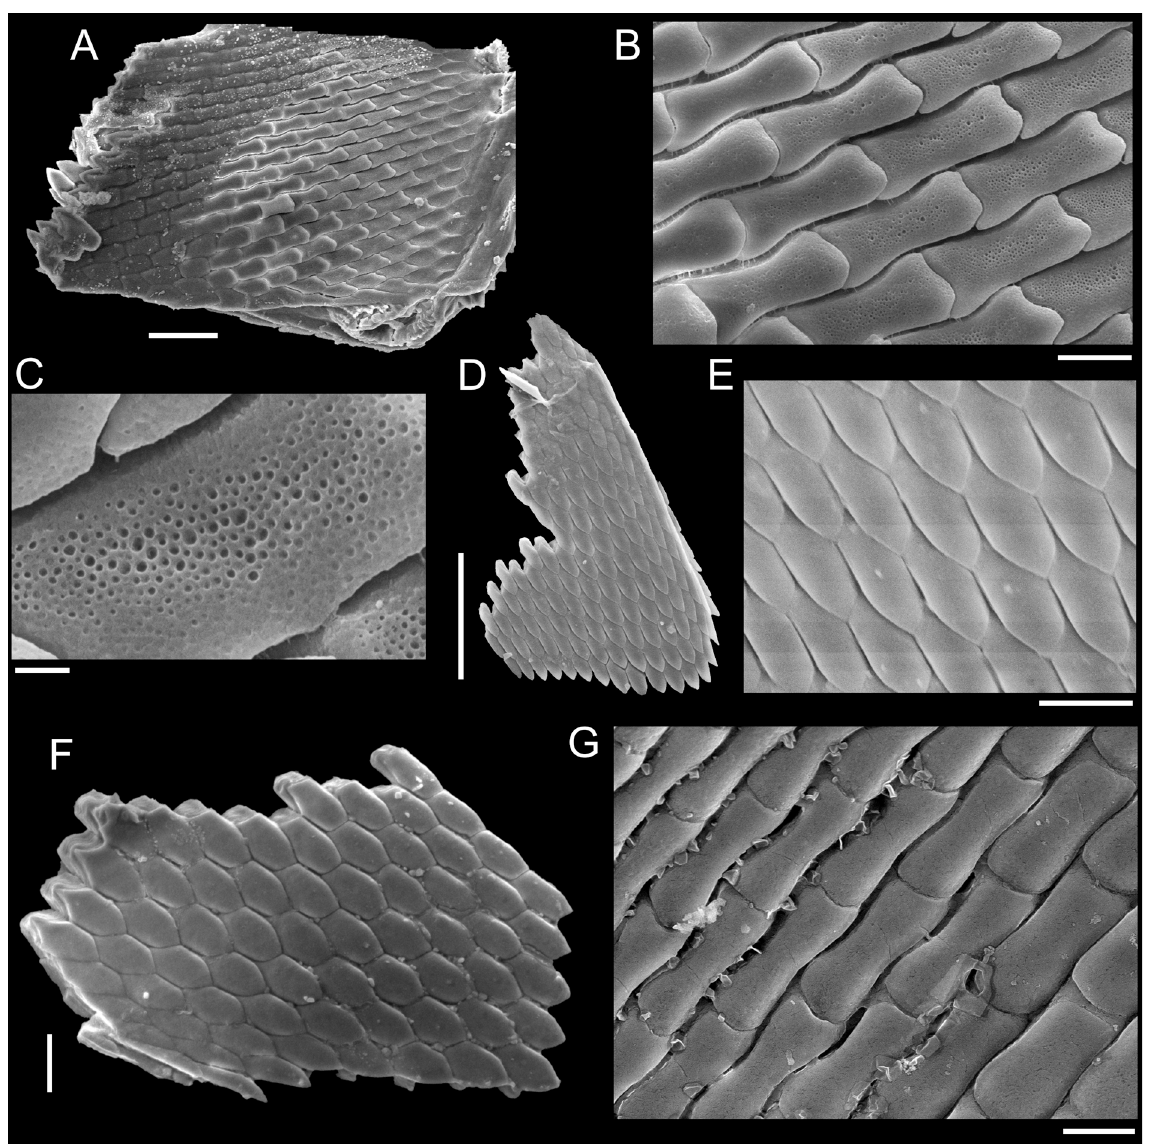
Fig. 26. Similiphora intermedia (C.B. Adams, 1850). A–C, F . MNRJ 18751. D–E . MNRJ 30854. G . MNRJ 29763. A–G . Jaw, outer (A–C, G) and inner (D–F) sides. Scale bars: A = 20 µm; B, G = 5 µm; C = 1 µm; D = 50 µm; E–F = 10